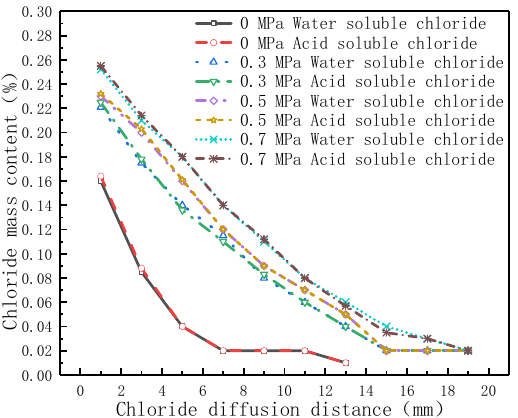
Figure 4. Test results of chloride in NaCl diffusion source solution under different hydrostatic